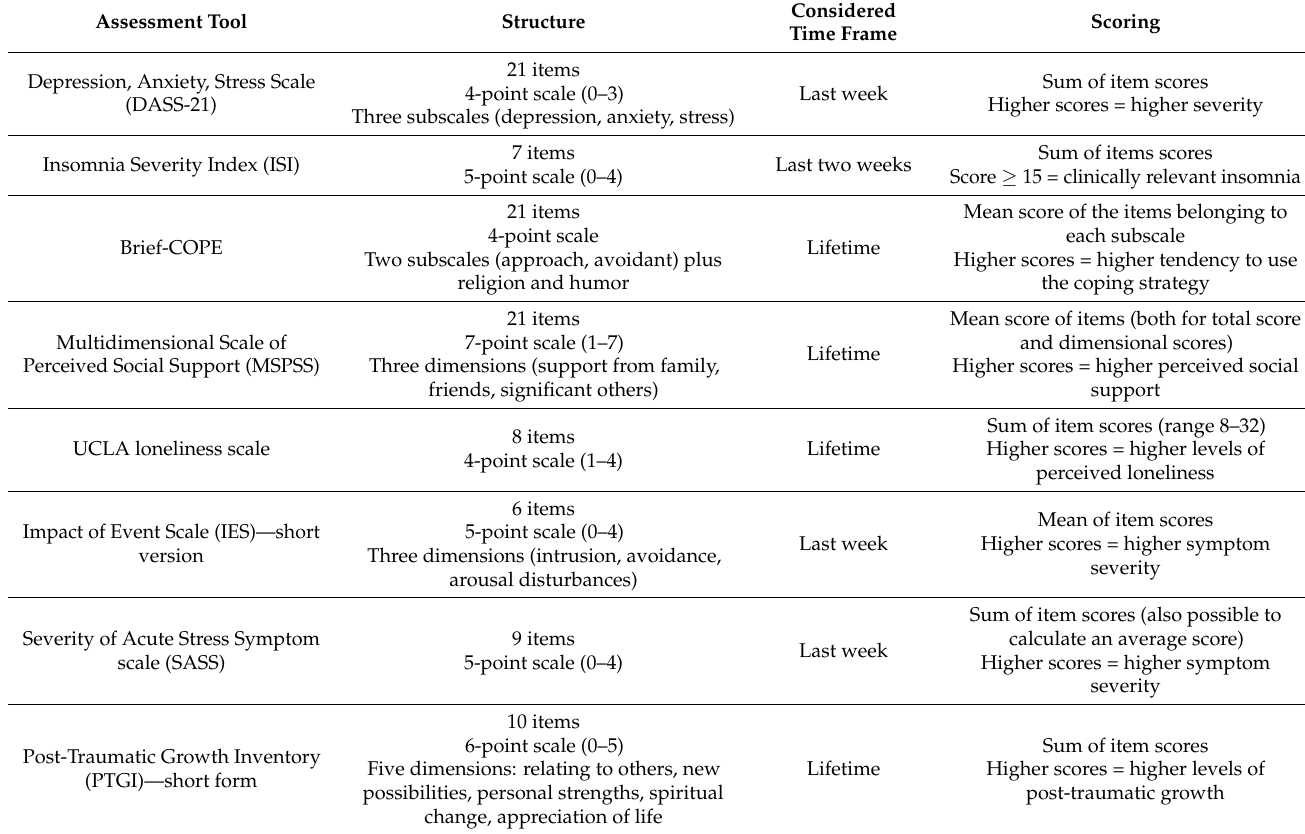
Table 1. Clinical scales used for psychopathological assessment in the COMET